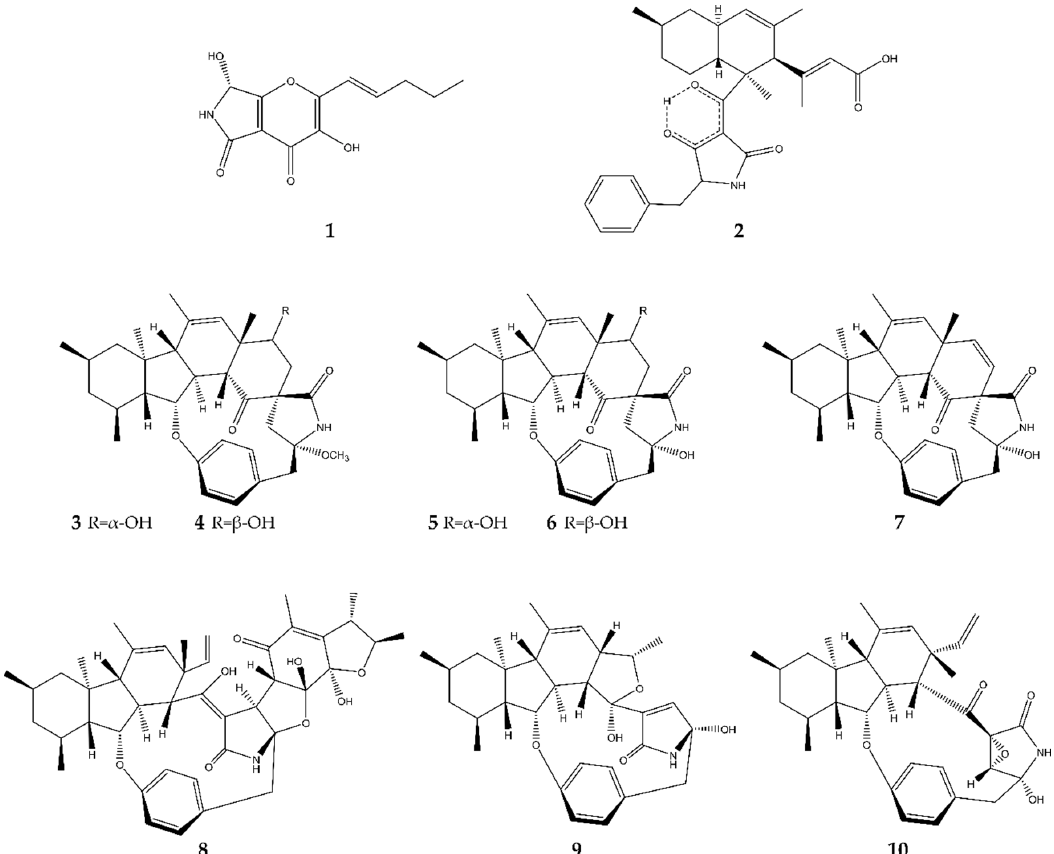
Figure 2. Overview of antimicrobial pyrrolidines in marine fungi discovered between 2015 and the present: pyranonigrin F ( 1 ), lindgomycin ( 2 ), pyrrospirone C–F and I ( 3 – 7 ), penicipyrrodiether A ( 8 ), penicipyrroether A ( 9 ), and GKK1032C ( 10 ).